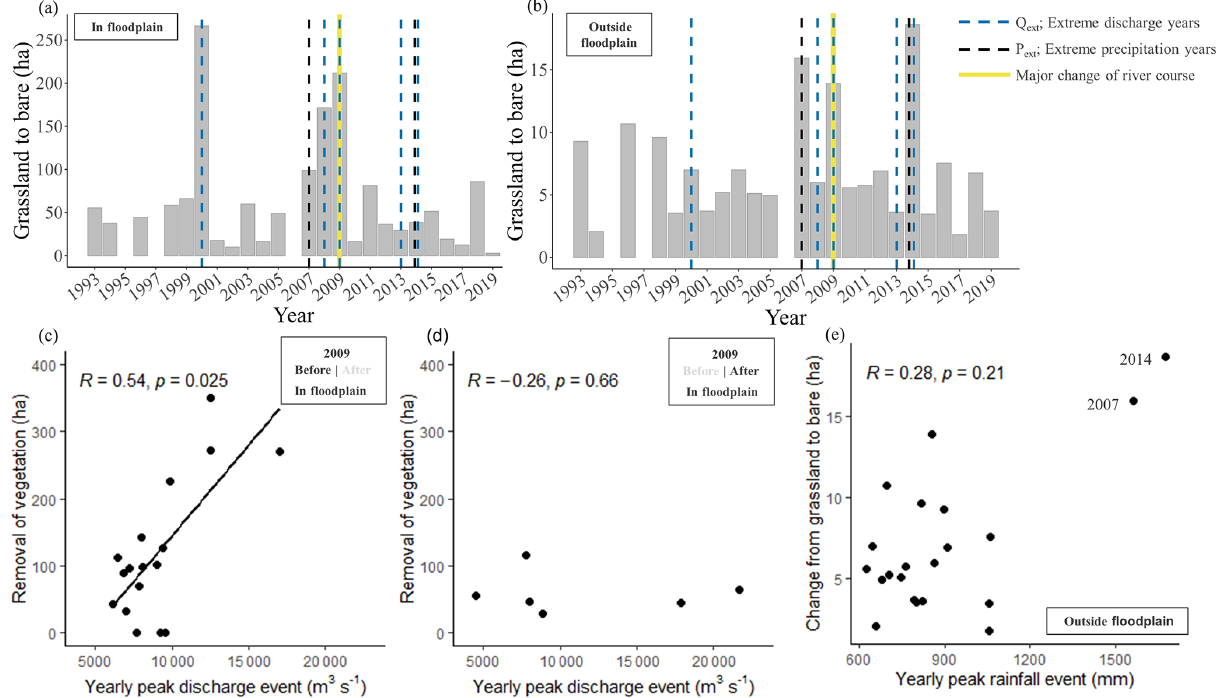
Figure 6. Environmental variables related to land cover dynamics derived from the level 1 classification series. (a, b) Annual transitions from grassland to bare substrate in hectares (orange bars) and years that experienced extreme discharge events ( > 12500m 3 s − 1 ) and peak precipitation events within the floodplain (a) and outside the floodplain (b) . Panels (c) , (d) and (e) show correlation tests of environmental and land cover variables. Panels (c) and (d) show the annual removal of vegetation (the transition of Sal forest and grassland towards water and bare substrate) as related to the magnitude of yearly peak discharge before the channel relocation (c) and after the channel relocation (d) . Panel (e) shows the yearly peak rainfall events (millimetres in a month) and the transition of grassland to bare substrate. Note the difference in scale on the y